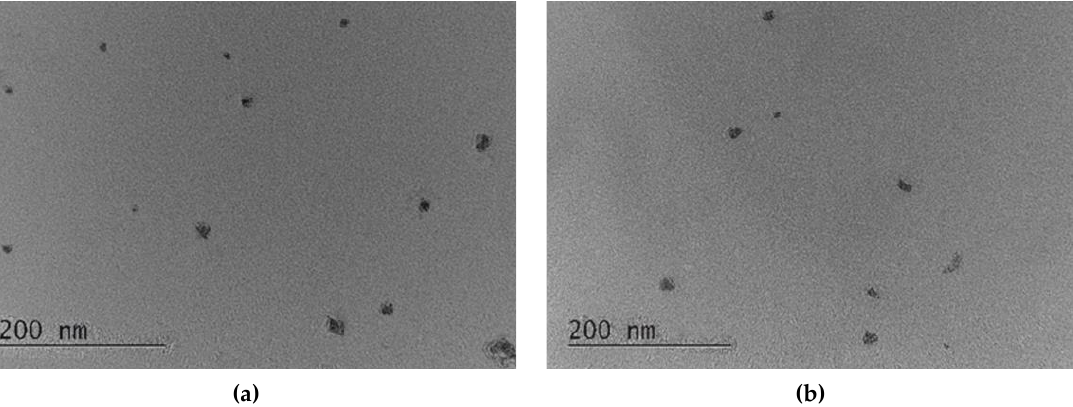
Figure 3. Transmission electron microscopy of empty ( a ) and doxorubicin/resveratrol-loaded mi-